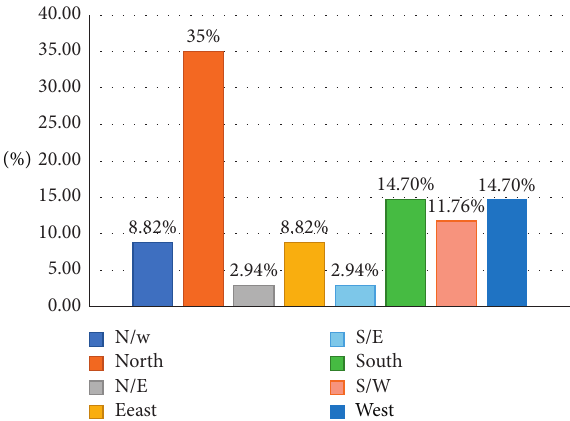
Figure 5: Root distribution toward the